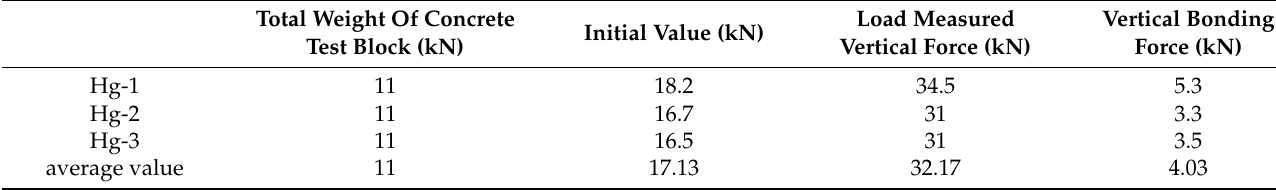
Table 7. Vertical force of test piece with geotextile on the contact surface.